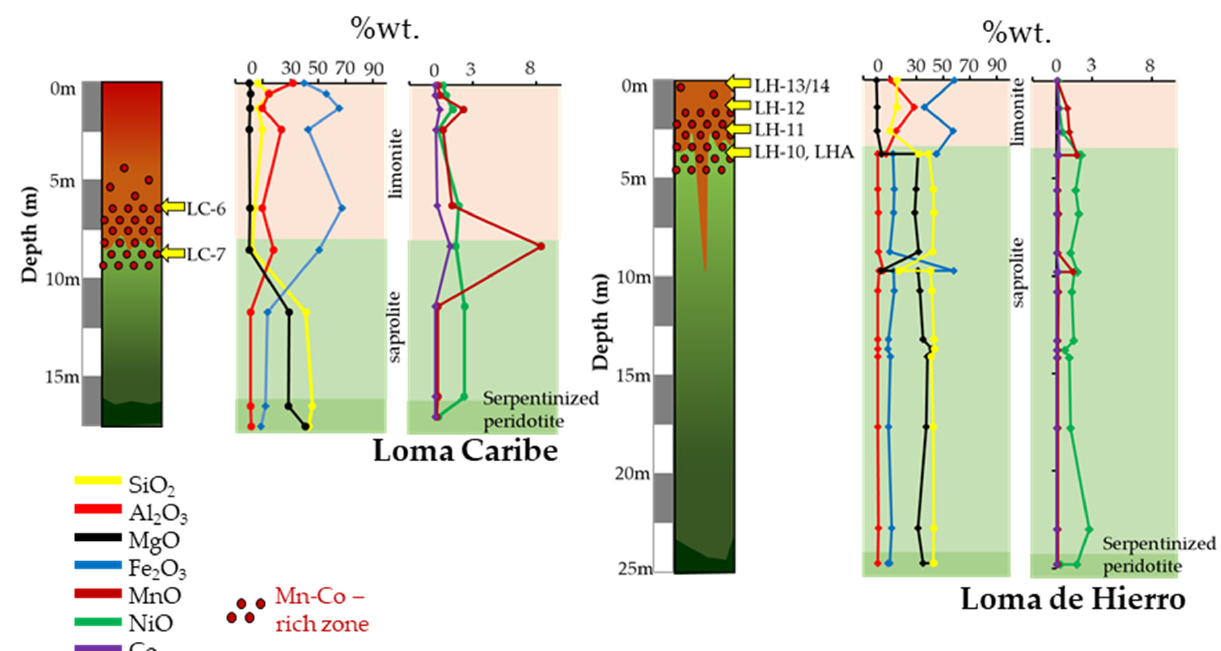
Figure 2. Ni–Co laterite profile from Loma Caribe (Falcondo, Dominican Republic) and Loma de Hierro (Venezuela) ore deposits, showing the location of the samples studied in this paper with major and relevant minor element contents.